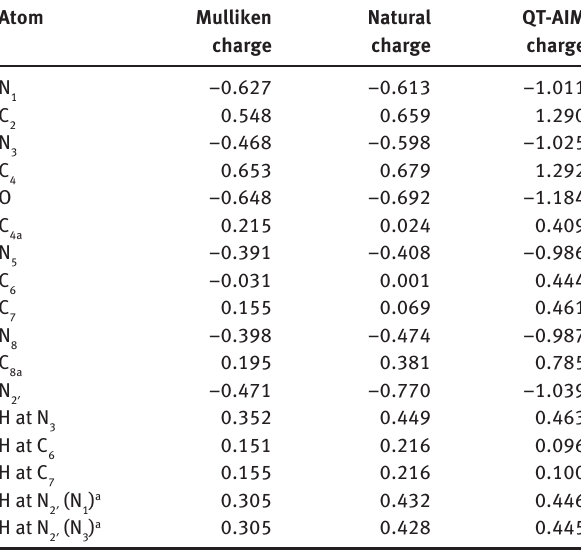
Table 1 Comparison of atomic partial charges obtained by